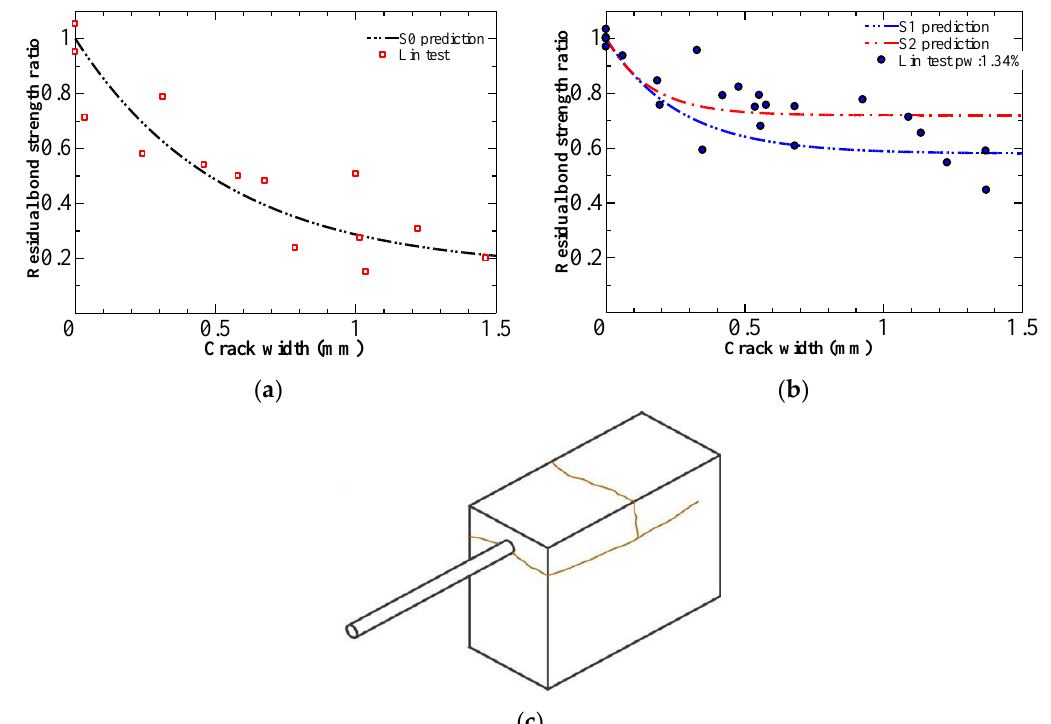
Figure 16. Comparison of the proposed formulas with study by Law et al.: ( a ) S0 prediction com- pared with specimen by Law et al.; ( b ) typical corrosion-induced cracks in specimen by Law et al. [16].